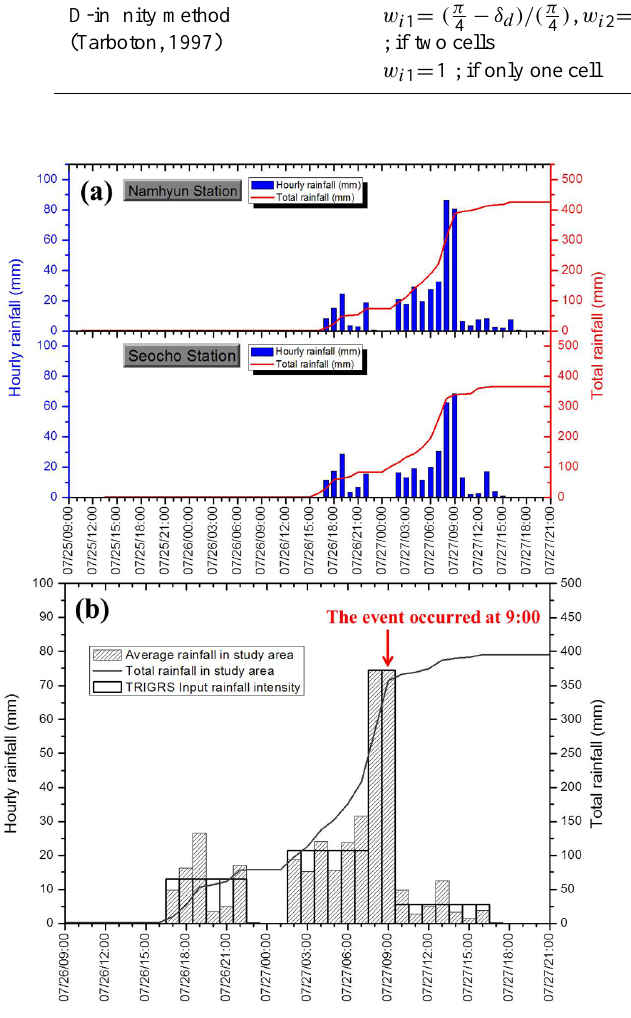
Fig. 8. Hourly and total rainfall distribution on 25–27 July 2011: (a) rainfall at Namhyun and Seocho stations and (b) TRIGRS input rainfall intensity.